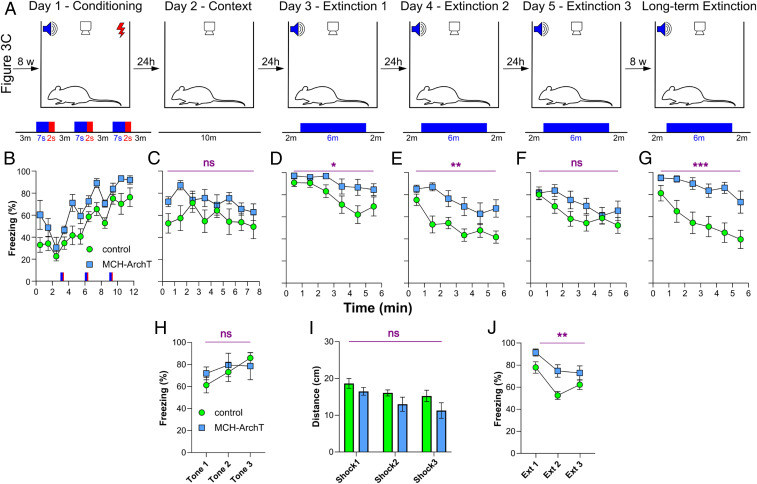
Role of MNs in chronic and relapsing fear behavior. (A) Protocol of fear reconditioning (the initial conditioning with MN photoinhibition is shown in Fig. 3C). (B–F) Chronic effects of MN photoinhibition on freezing corresponding to test phases shown in A. Each point shows a 60-s average (30 s before and 30 s after the point). (G) MN photoinhibition produces chronic, relapse-prone, dysfunctional fear extinction. (H) Chronic effect of MN photoinhibition on freezing during each 7-s tone on the conditioning day. (I) Chronic effect of MN photoinhibition on distance moved during conditioning shocks. ns, P > 0.1. (J) Chronic effect of MN photoinhibition on mean freezing during each 6-min extinction session on extinction days 1–3. Data are mean ± SEM of seven MN-ArchT mice and six control mice. ns, P > 0.05; *P < 0.05; **P < 0.01; ***P < 0.005 for ArchT vs. control. More details on the statistical tests are provided in Results.